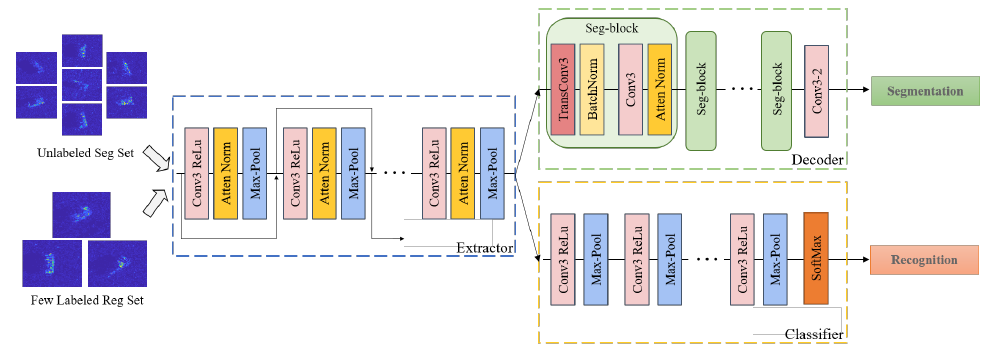
Figure 1. Baseline